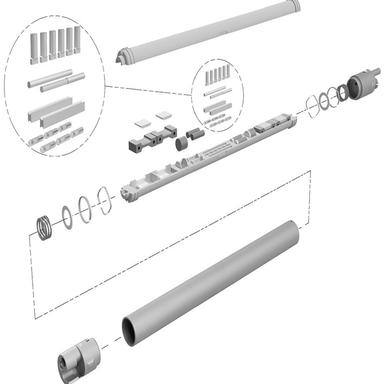
Schematic of the standard capsule assembly.